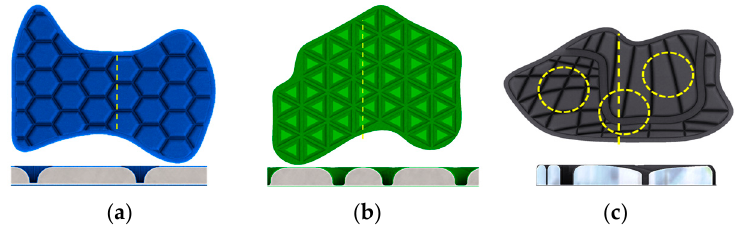
Figure 1. Computer-aided design reconstructions of approved paddings showing ( a ) hexagonal, ( b ) triangular and ( c ) irregular patterns with enlarged cross-sectional view showing variation within